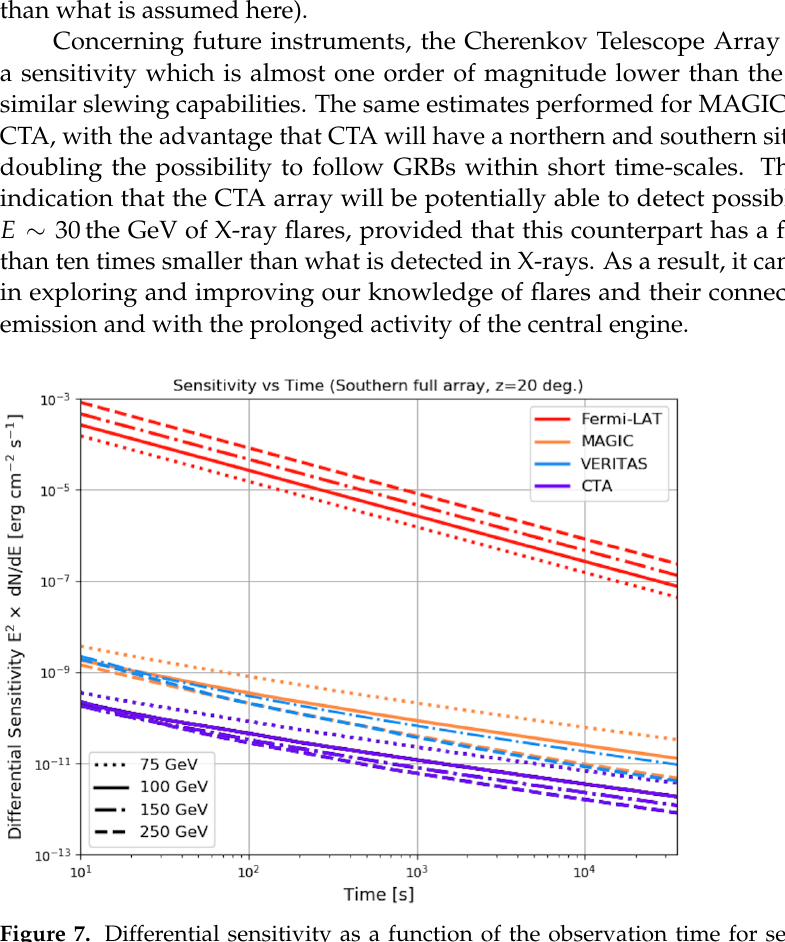
Figure 7. Differential sensitivity as a function of the observation time for several HE and VHE instruments (Fermi-LAT, MAGIC, VERITAS and CTA) at four selected energies (75, 100, 150, 250 GeV). From